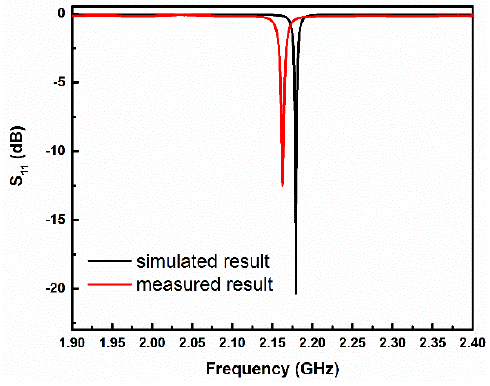
Figure 6. Simulated and measured reflection coefficients S 11 of the designed humidity sensor at 30% relative humidity (RH).